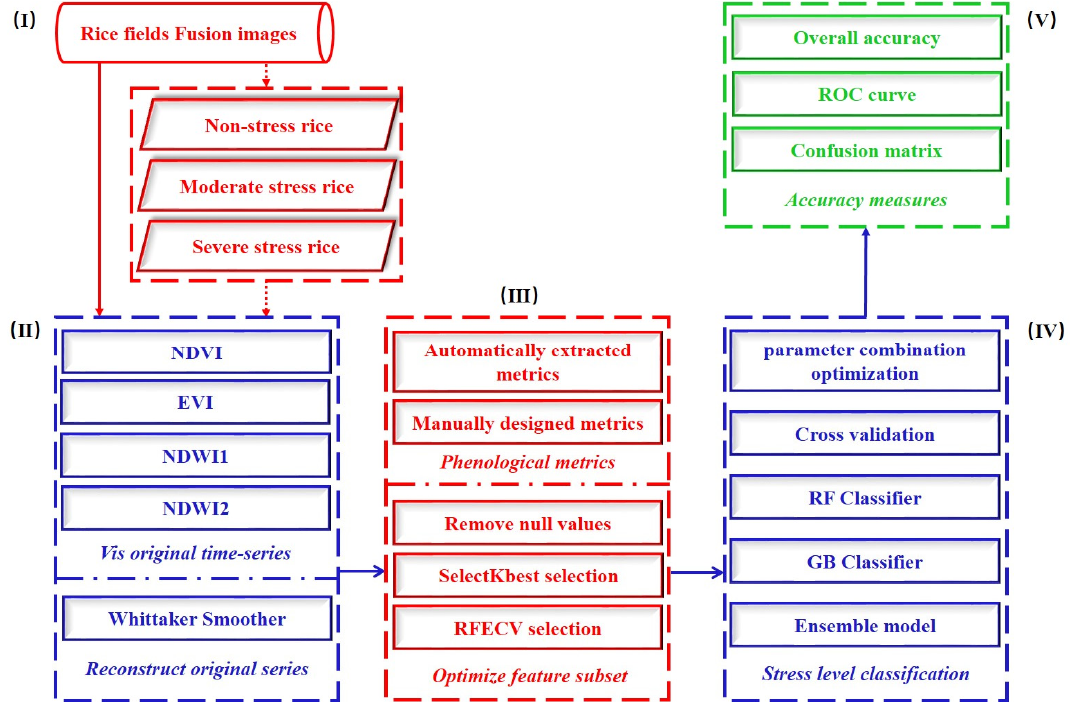
Figure 2. Overview of methodology.